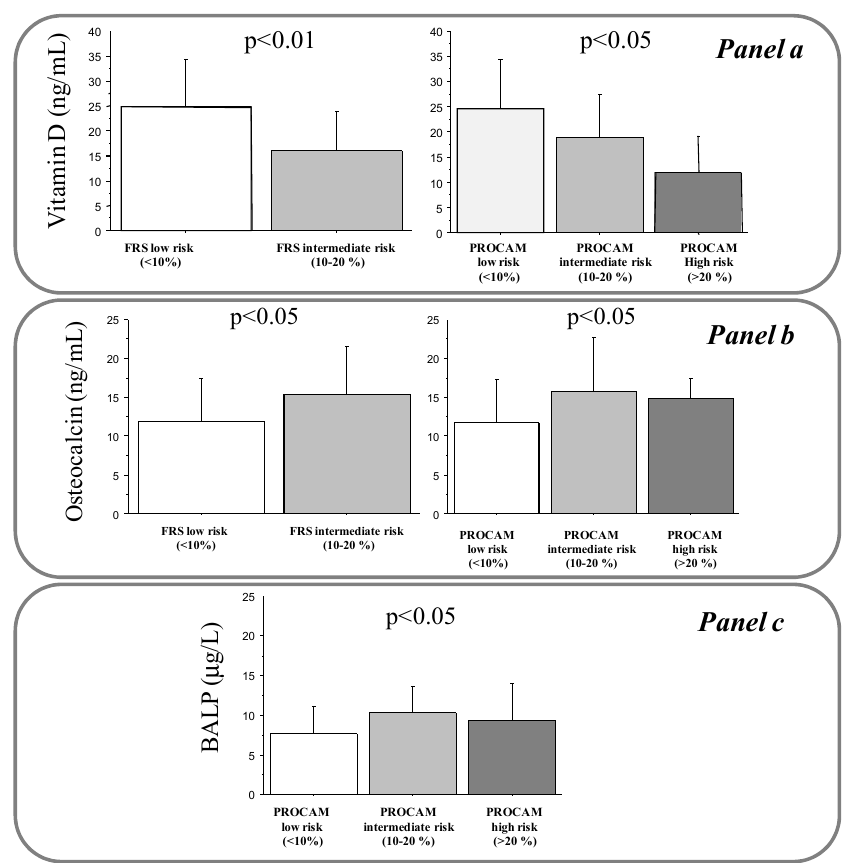
Figure 1. Levels of 25(OH)D (panel a ), OC (panel b ), and BALP (Panel c ) according to FRS and PROCAM risk stratification in the studied population. p for trend.